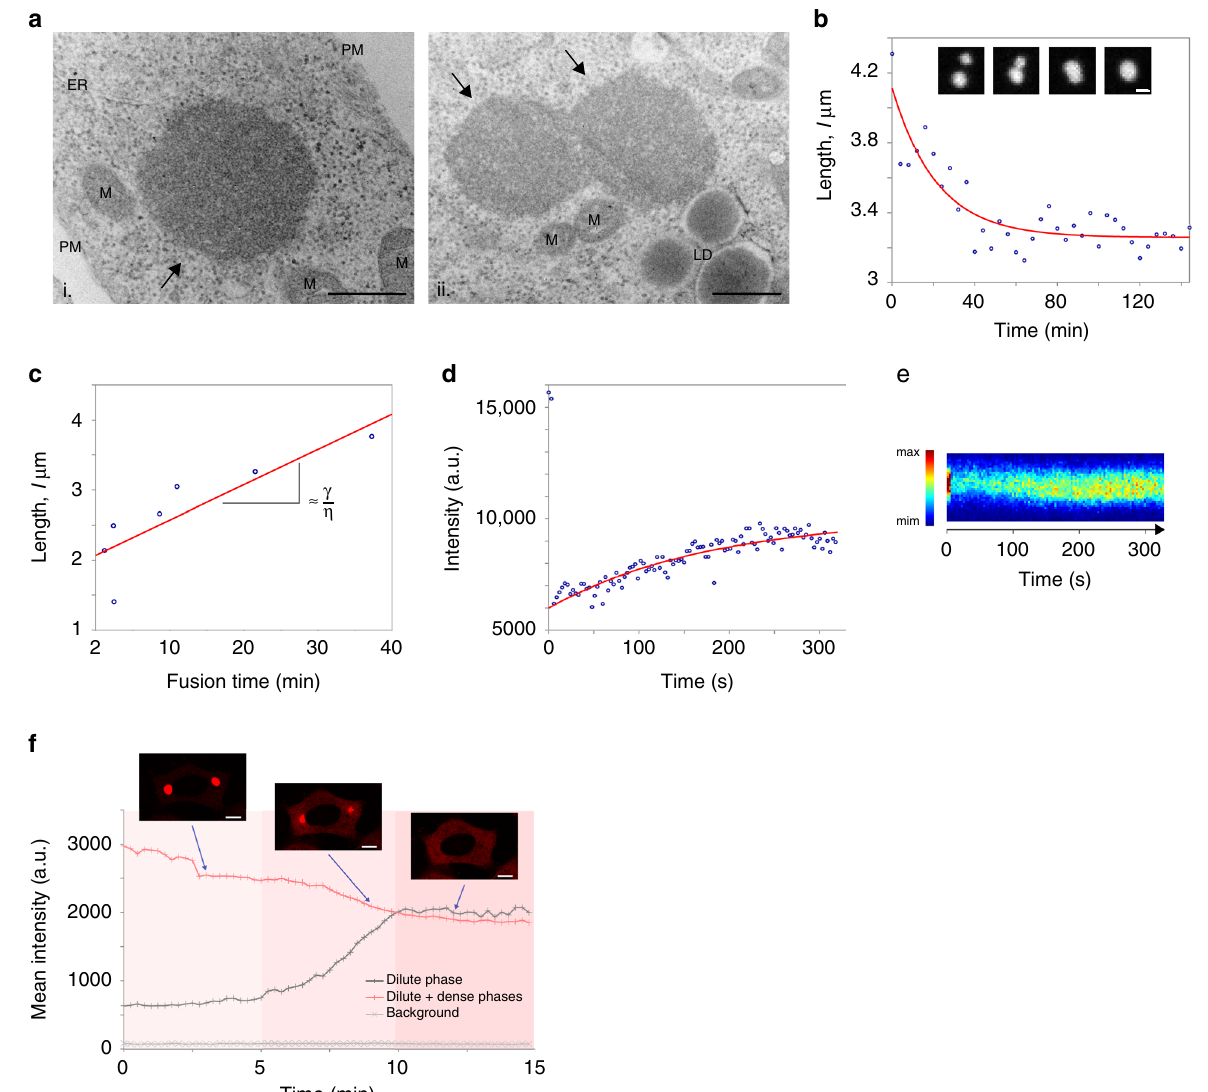
Fig. 2 ArtiG mCh recapitulate the main properties of phase-separated liquid droplets. a Ultrastructure of an individual ArtiG mCh (i, black arrow) and of two ArtiG mCh (ii, black arrows) undergoing fusion in HeLa cells, 24 h after transfection of mCherry-FFm construct. ER endoplasmic reticulum, M mitochondrion, LD lipid droplet, PM plasma membrane. Scale bar, 500 nm. b Temporal evolution of the distance between two ArtiG mCh fusing with each other and relaxing into a single droplet within a characteristic time of 40 min. Insert: time-lapse of the corresponding fusion event. Scale bar, 2 µ m. c Plots of the characteristic relaxation time of different fusion events as a function of the diameter, with the slope giving the capillary velocity (ratio between the surface tension γ and the viscosity η ). d Example of recovery of fl uorescence intensity after photobleaching of a 2 µ m ArtiG mCh . e Kymograph representation of the fl uorescence recovery of the ArtiG mCh analyzed in d . f Dissolution of ArtiG mCh upon addition of 2.5 µ M of FK506 to the culture medium. Comparison of the temporal evolution of the total cytoplasmic fl uorescence (dilute and dense phases) with the dilute cytosolic mCherry-FFm fl uorescence (dilute phase) as a function of ArtiG that deformed under mechanical stress relaxed back in a spherical shape (e.g., after being trapped between the nuclear and plasma membranes; Supplementary Fig. 2b). These dynamics and the spherical morphology indicate a liquid – liquid demixing state of the ArtiG.